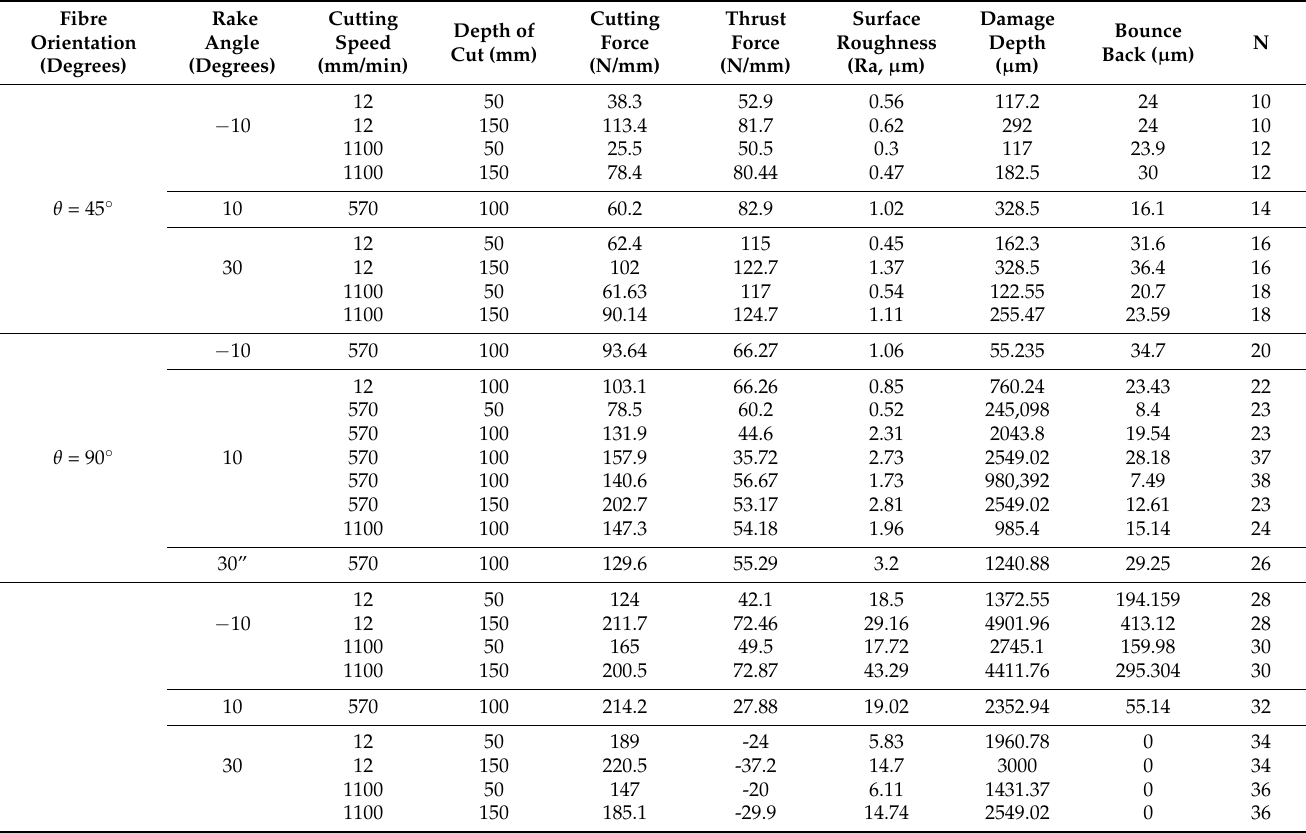
Table 4. Experimental results for RMS design.